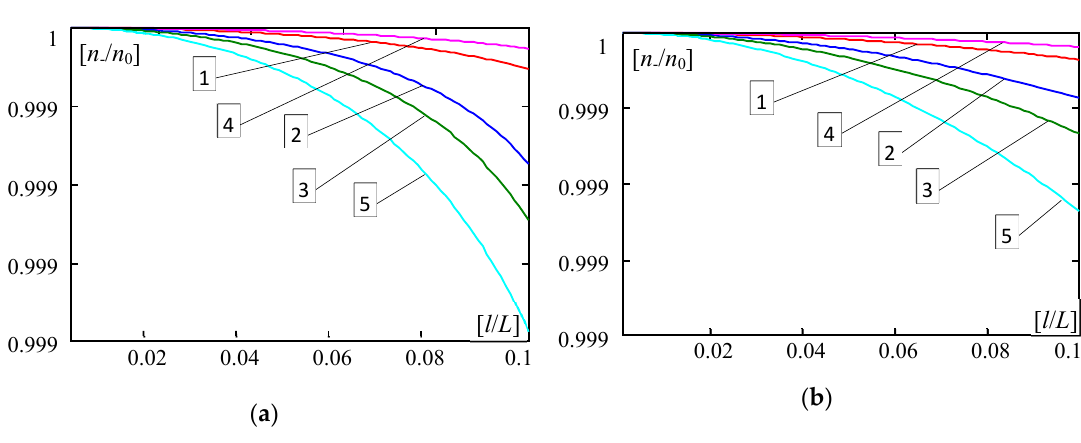
Figure 4. Values of ratios n _ / n 0 versus l / L ( E ”/ E ’ = 0.3, d / L = 0.01, m = 1). ( a ) For κ = 0.0001; ( b ) For κ = 0.000001. (1— γ by (28) 1 , 2— γ by (28) 2 , 3— γ by (28) 3 , 4— γ by (28) 4 , 5— γ by (29)).